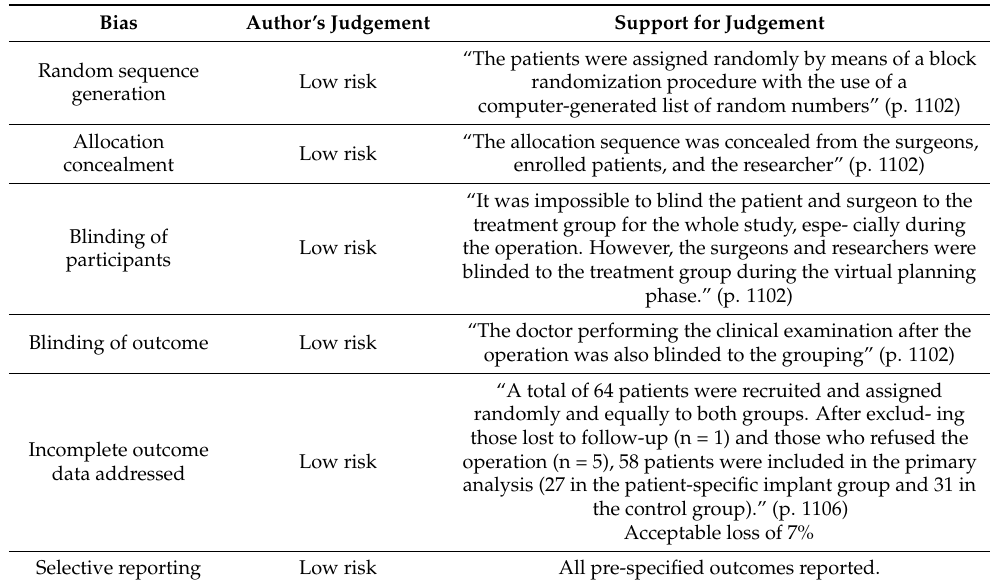
Table A4. Risk of bias analysis of Li et al. (2021) using Cochrane Collaboration’s risk of bias tool.